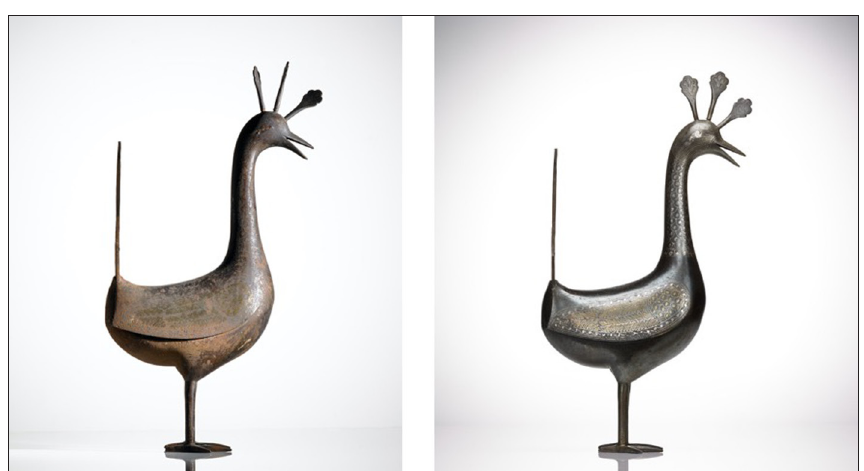
Fig. 6 : Peacock, steel with inlaid gold and silver decoration, before (left) and after (right) conservation, Iran (Isfahan), late nineteenth century. F131, given by Miss E. G. Tanner in 1932. © Holburne Museum, Bath. Photo: